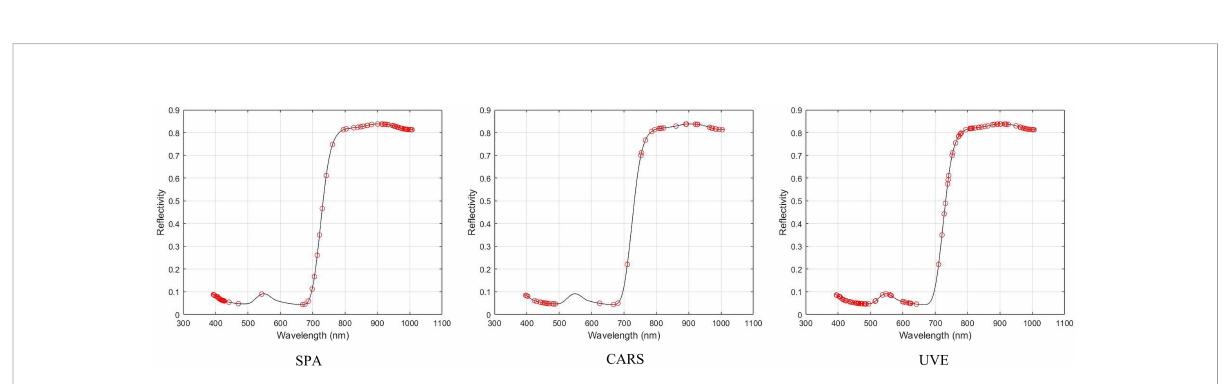
FIGURE 8 The characteristic bands screened by SPA, CARS and UVE algorithms.